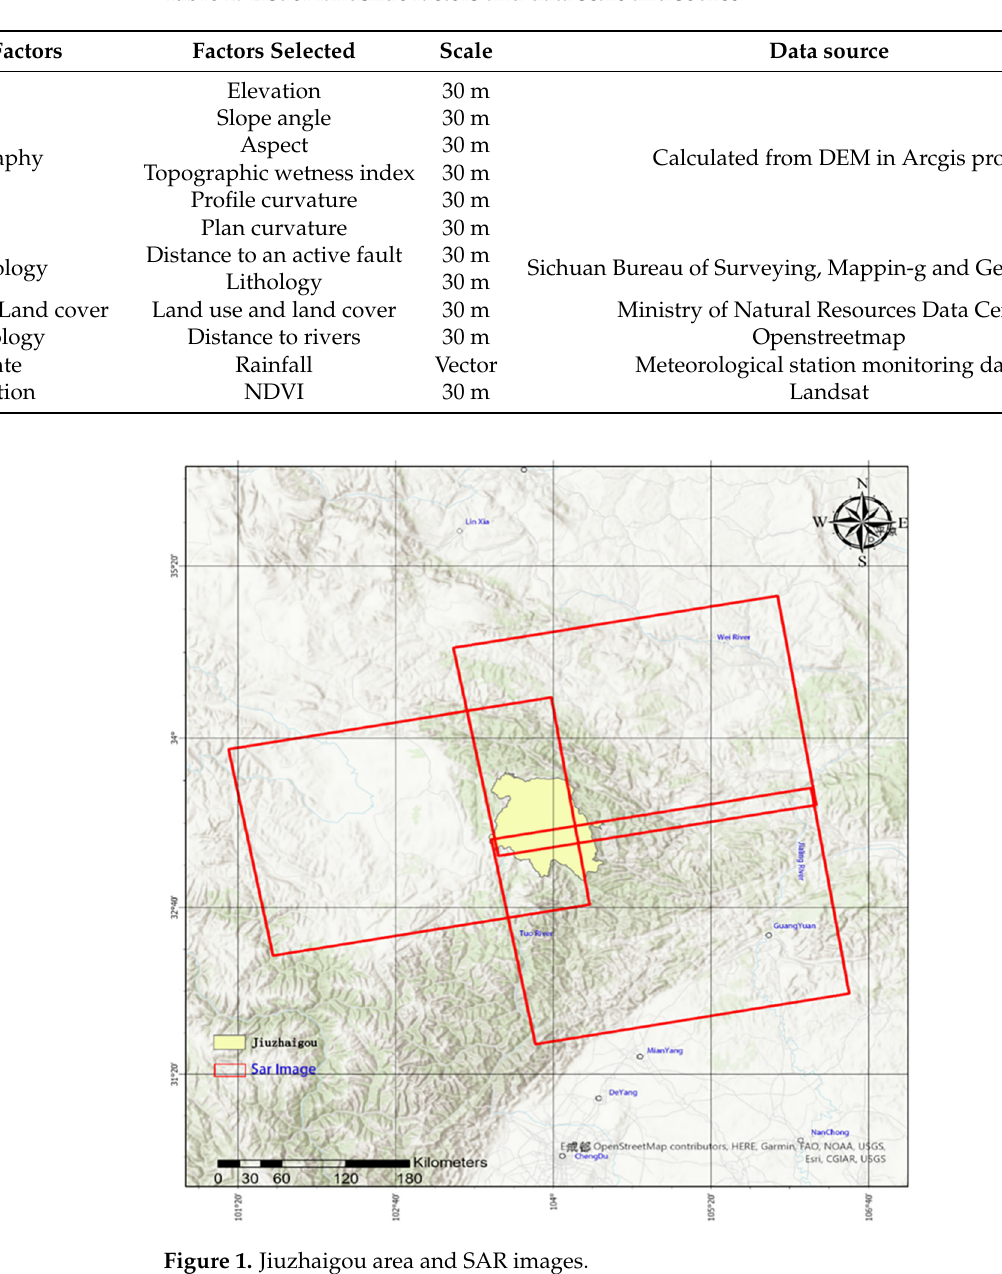
Table 2. List of landslide factors and data scale and source.